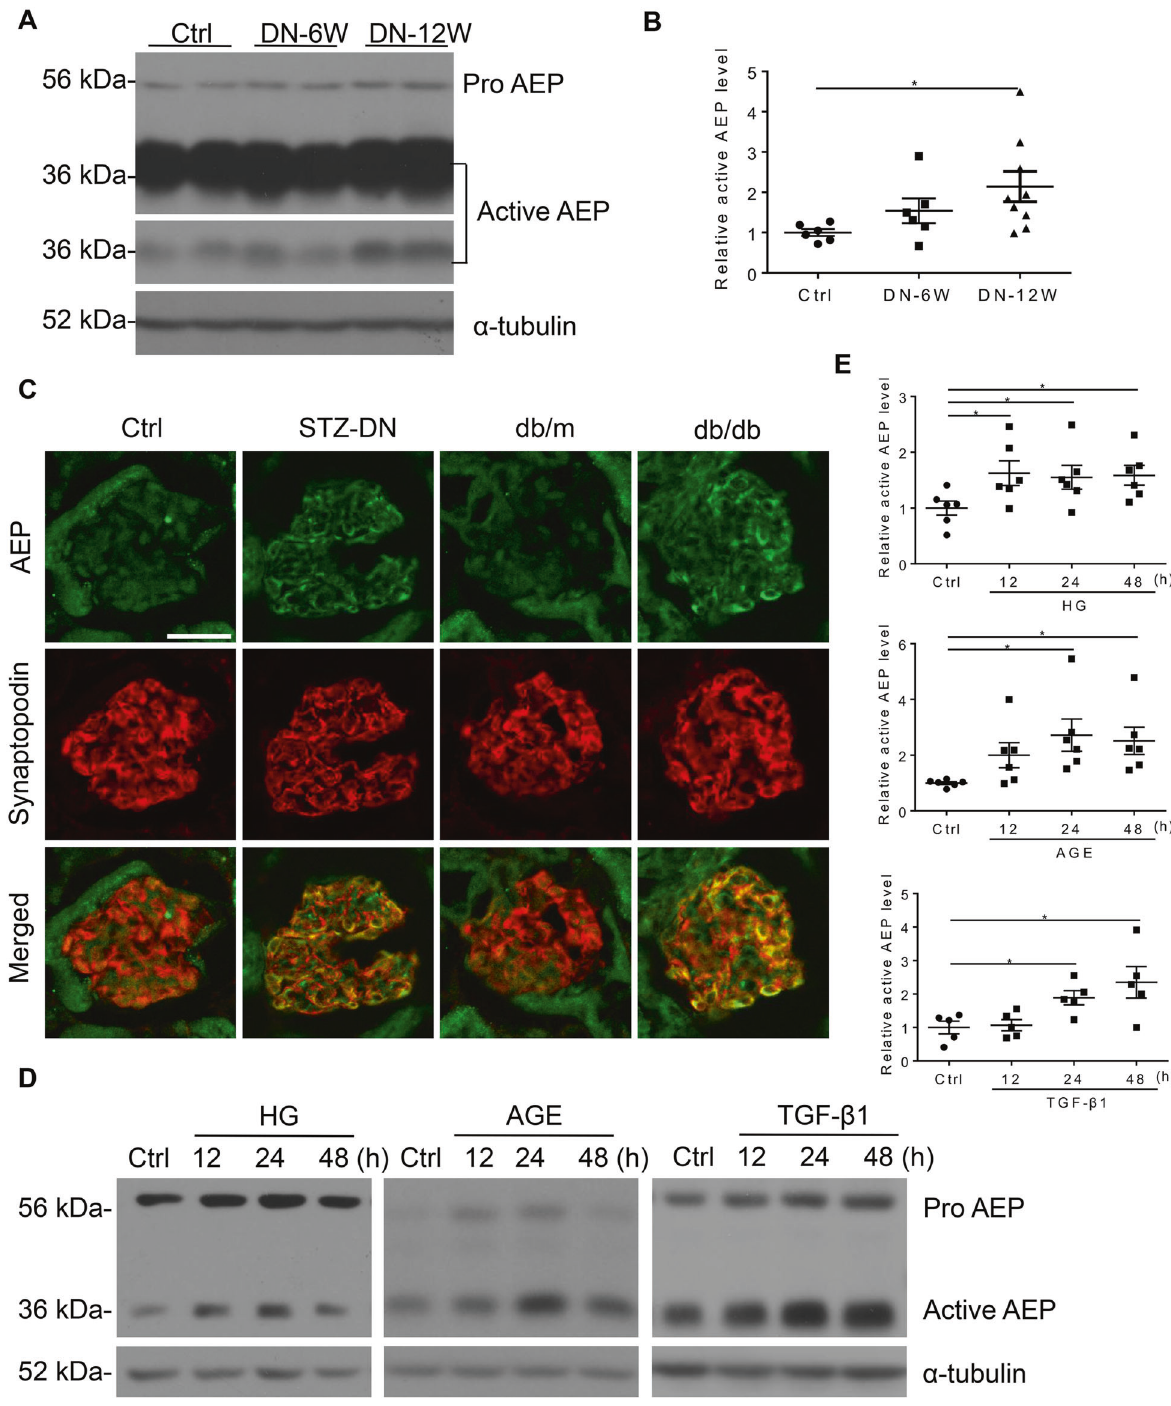
Fig. 1 Asparaginyl endopeptidase (AEP) was upregulated in podocytes under diabetic conditions in vivo and in vitro. Representative western blot ( A ) and summarized data ( B ) showing AEP protein levels in the kidney cortex of control (Ctrl) and streptozotocin (STZ)-induced diabetic nephropathy (DN). N = 6 – 9. C AEP (green) colocalization with Synaptopodin (red) in the glomeruli of control mice and DN mice, db/m mice, and db/db mice. Scale bar: 25 μ m. Representative western blot ( D ) and summarized data ( E ) showing AEP protein levels in human podocytes (HPCs) treated with high glucose (HG) ( fi nal concentration 30 mmol/L), and AGE (100 μ g/mL), TGF- β 1 (5 ng/mL). N = 5 – 6. * P < 0.05, data were represented as mean ± SEM. As the above in vivo and in vitro experiments showed the increase in Desmin and cleaved Caspase 3 expression, suggesting detrimental role of AEP knockdown and inhibition, we examined that reduced AEP expression exacerbated HG-induced podocyte whether AEP overexpression can mitigate the HG- or TGF- β 1- injury (Fig. 4E, F). Similar podocyte damage was aggravated in induced podocyte cytoskeleton disarrangement and cell injury. TGF- β 1-stimulated cells (Fig. S6C, D).